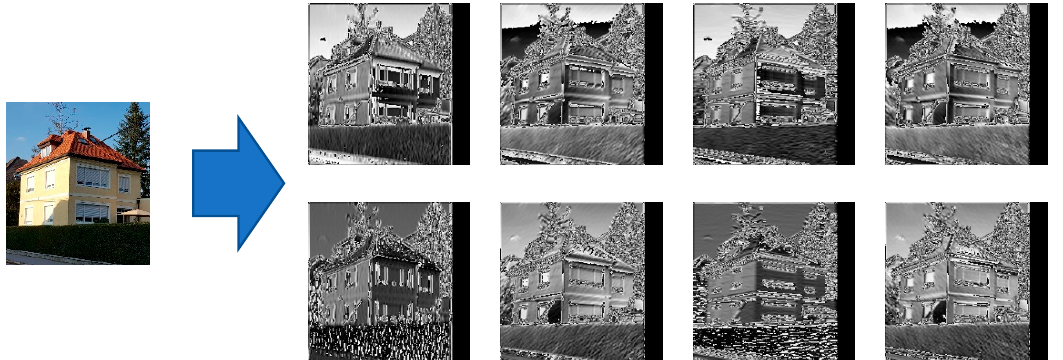
Figure 16. E ff ect of the Gabor filters on an input house image: The top row images are produced by Gabor filters with a kernel size 5, sigma 2, and theta having the following respective values: 0, 45, 90 and 135 degrees (from left to right). The bottom row images are produced by Gabor filters with kernel size 5, sigma 5, and theta having the following respective values: 0, 45, 90 and 135 degrees (from left to right). (Source of input image: own image).